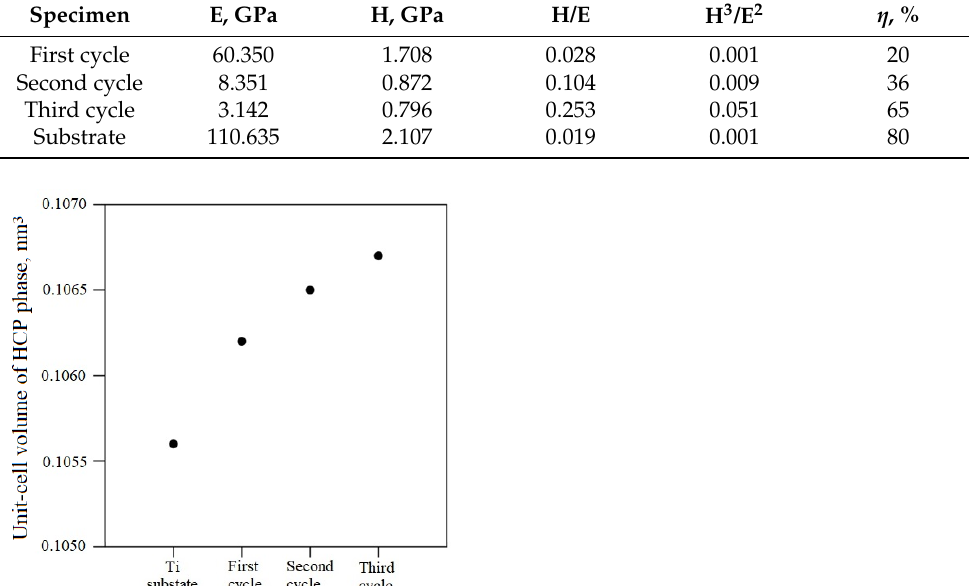
Figure 7. Unit-cell volume of the hexagonal closed-packed phase of the Ti substrate and after each cycle.